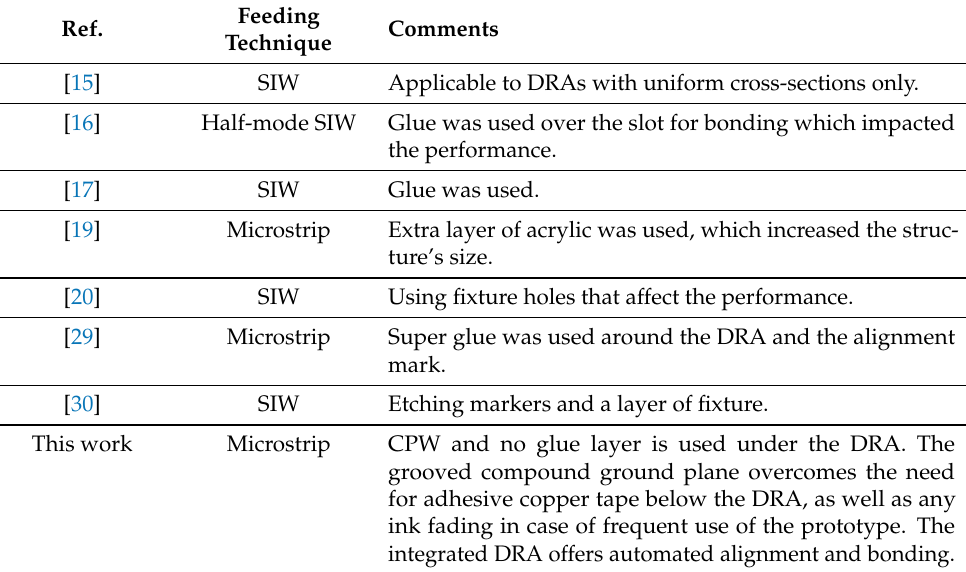
Table 2. Comparison between different techniques of DRA fixture and alignment with the pro- posed